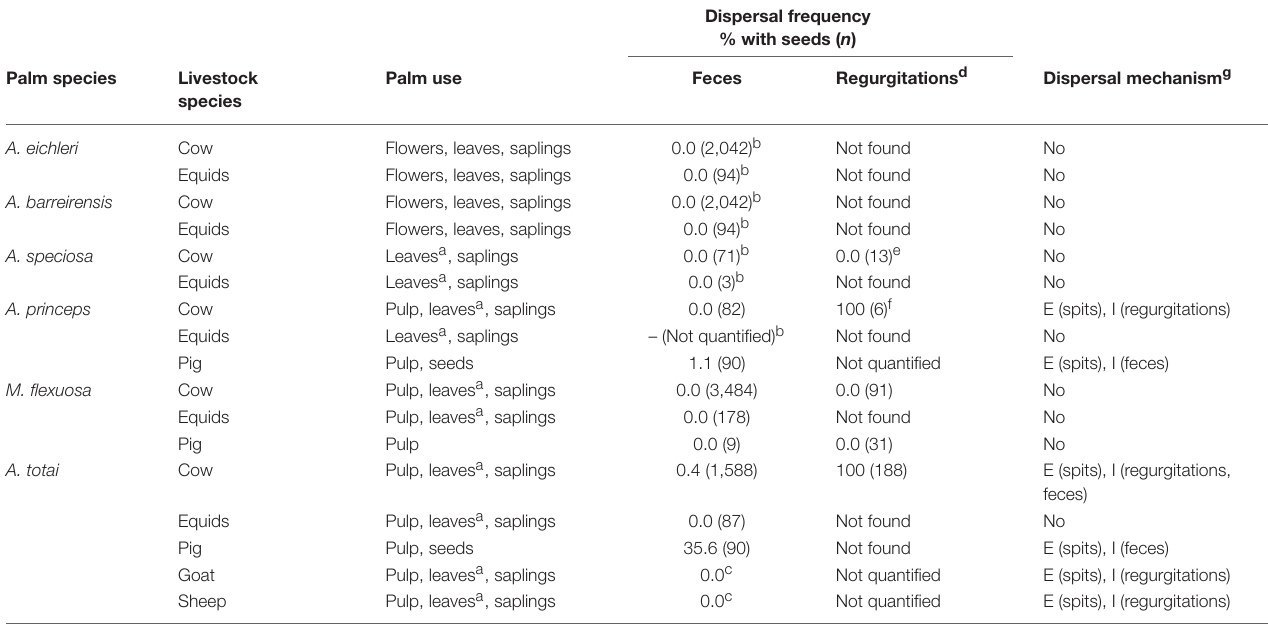
Dispersal frequency % with seeds ( n )